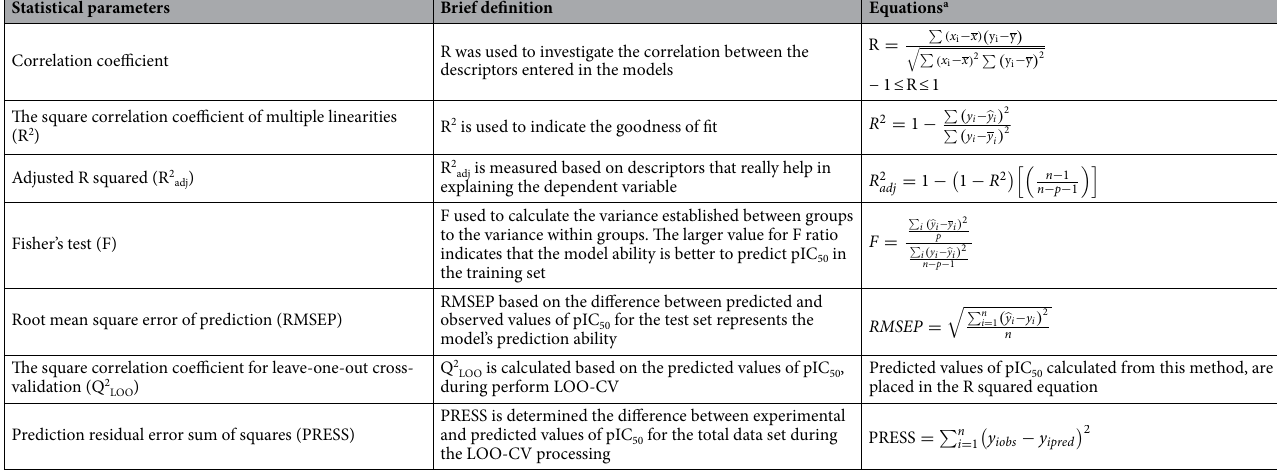
Table 3. Model performance parameters and their related equations. a y i , ŷ i , and i are experimental, predicted, and average values of pIC 50 respectively; p: the number of descriptors in the model; n: the number of samples.